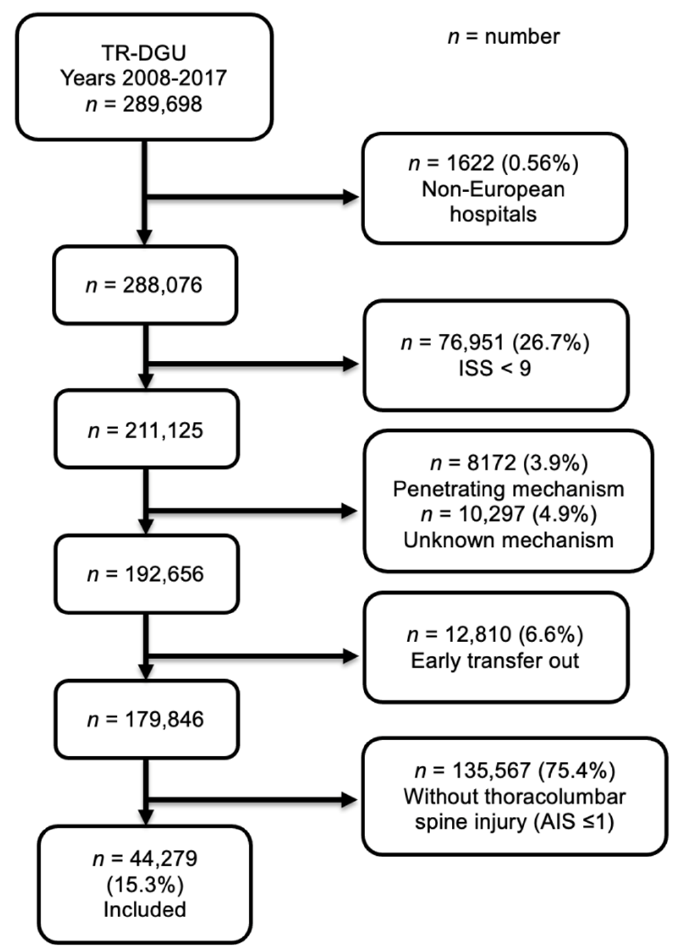
Figure 1. Patient inclusion flowchart.